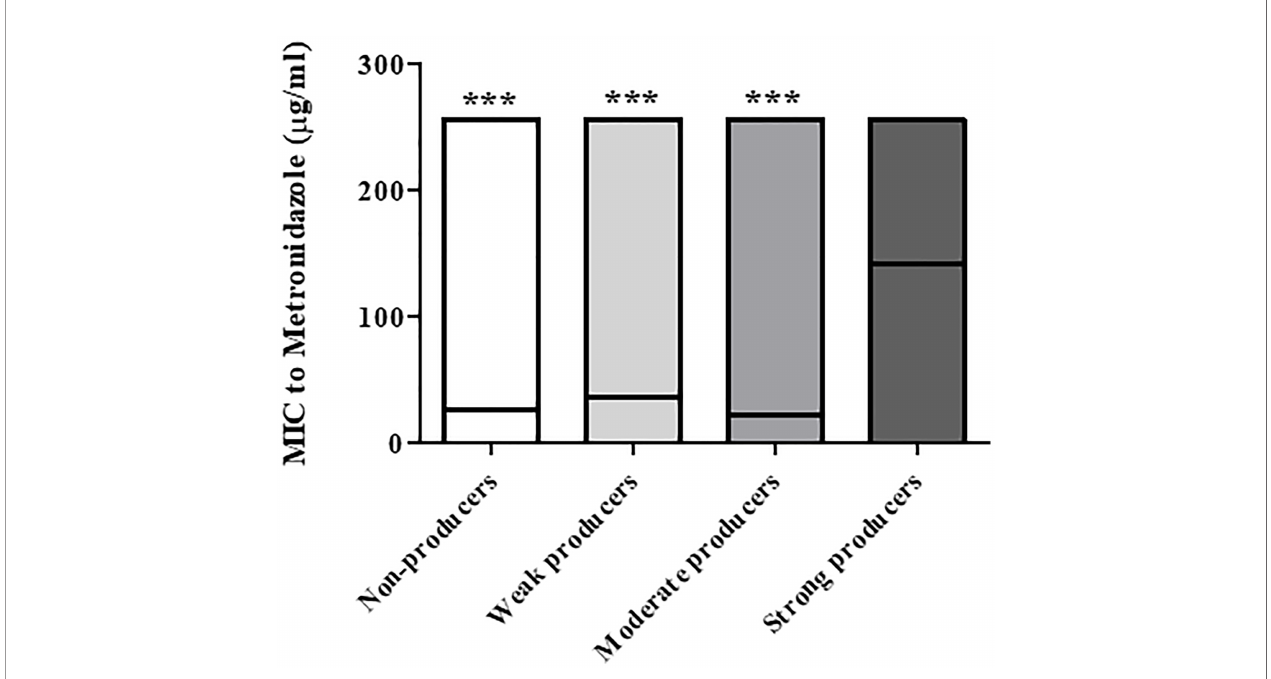
FIGURE 2 | Distribution of Metronidazole MIC values of non-bio fi lm producers, weak-, moderate- and strong bio fi lm-producing C. dif fi cile isolates. The minimal, maximal and average MIC values are shown (the average is indicated by the line within the bar) for each group of isolates (non-producers, weak-, moderate- and strong producers ’ groups). The mean metronidazole MIC of strong bio fi lm-producing isolates (n = 29) were signi fi cantly higher compared to MIC values of isolates that were non-producers (n = 57), weak producers (n = 14) and moderate producers (n = 23), *** p < 0.001. The p value represents the comparison of the mean MIC between the four categories of bio fi lm production capacity (ANOVA analysis).